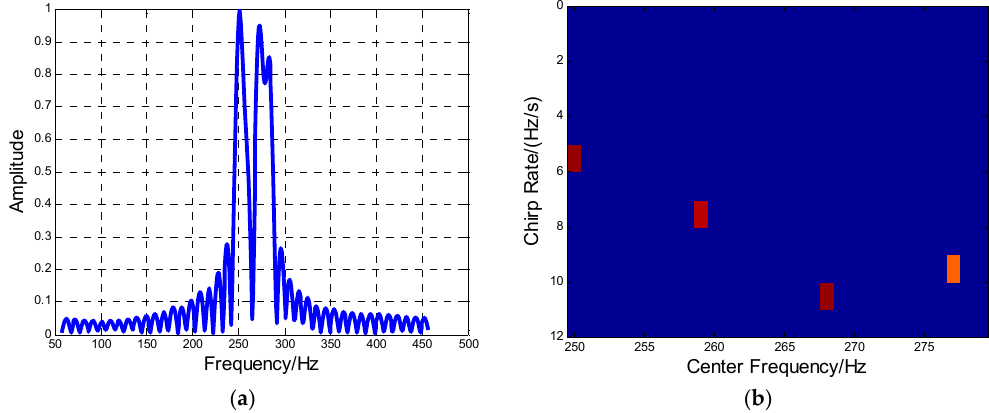
Figure 9. The four-aircraft MAF identification result. ( a ) Frequency spectrum of the MAF formation; ( b ) The MAF identification result by HBP. Table 4. Parameter estimation result.